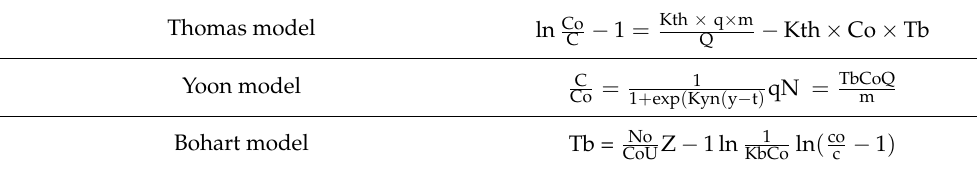
Table 1. Adsorption models.